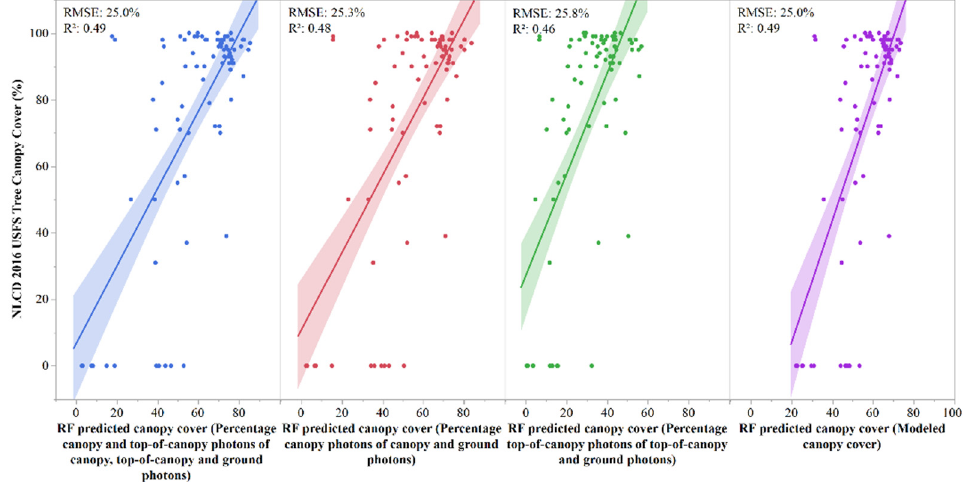
Figure 6. NLCD tree canopy cover versus RF-predicted canopy cover for SDFEC.